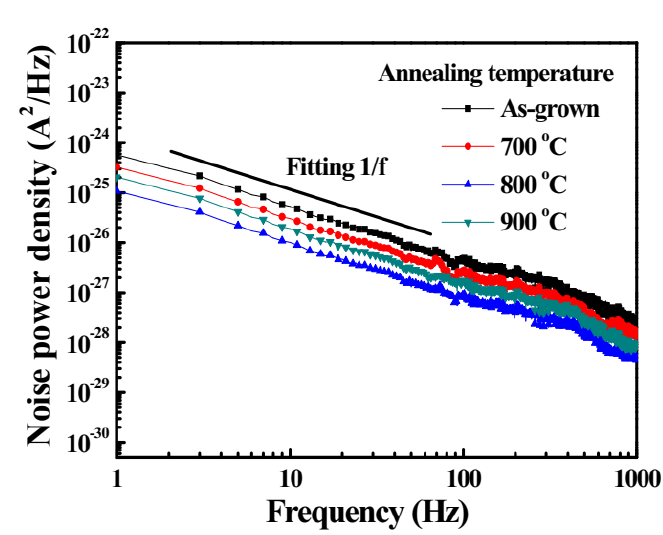
Figure 8. Noise power density of various Ga 2 O 3 -based MSM UVC-PDs as a function of frequency under a bias voltage of 5 V.